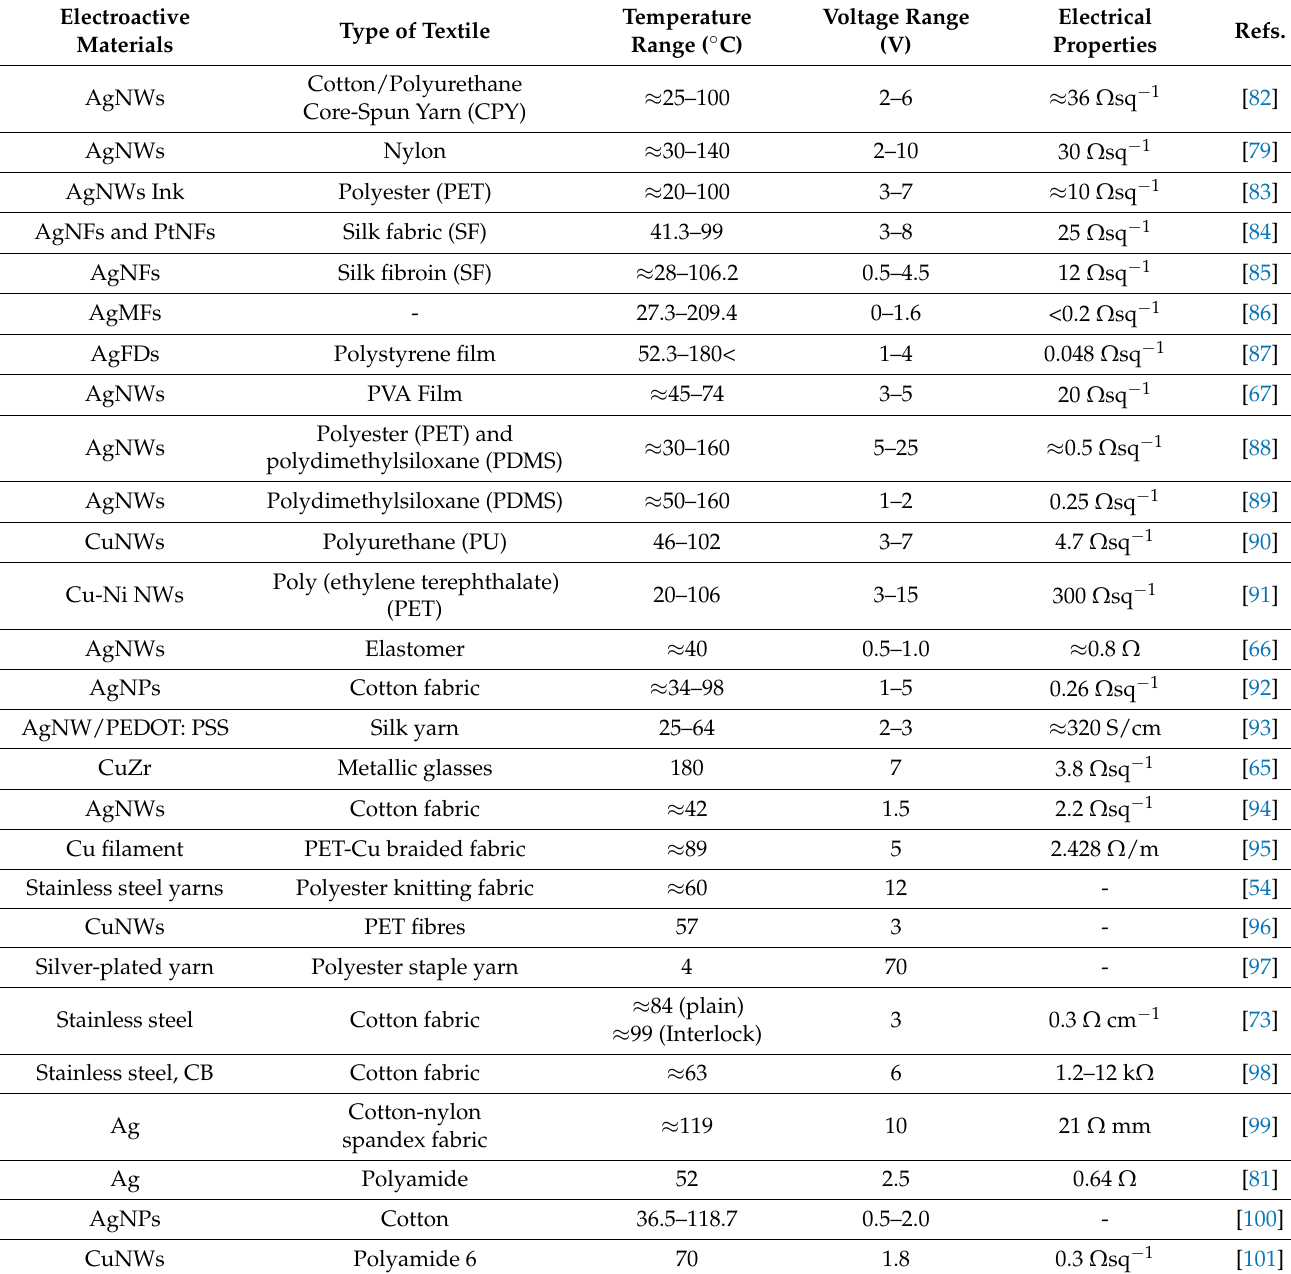
Table 3. Summary of metal-coated heating